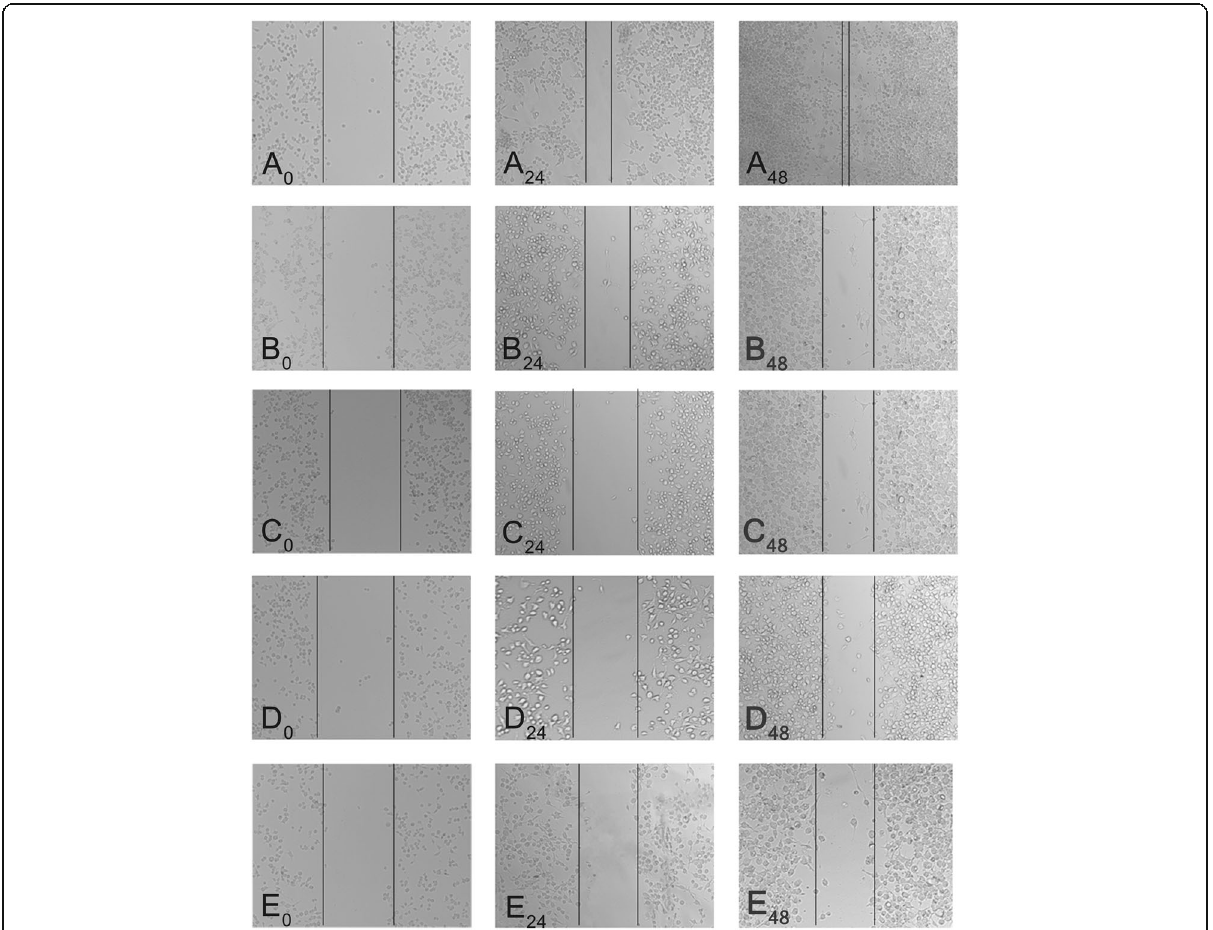
Fig. 7 Mitoxantrone alone and mitoxantrone loaded-CHP NPs showed impaired migration on wound healing assays. a DMSO, b mitoxantrone, c CHP-3, d CHP-2, e CHP-1. Images showed the gap of the scratched region at different times; A 0 , A 24 , and A 48 represent 0, 24, and 48 h of DMSO treatment,